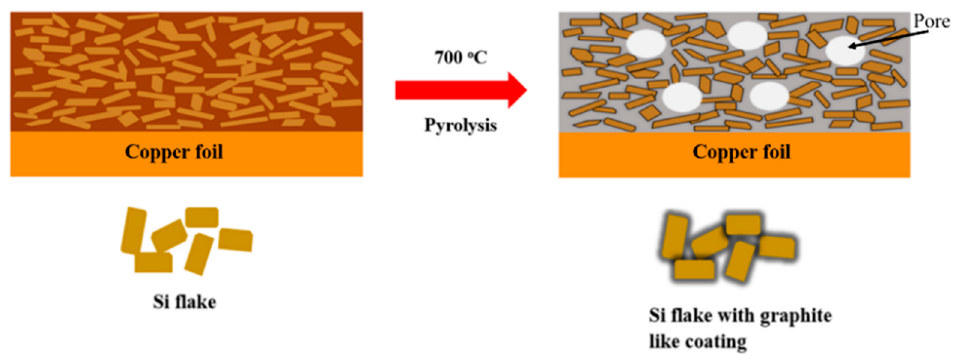
Figure 1. Schematic diagrams of silicon ‐ based anode before and after pyrolysis in argon at 700 °C.